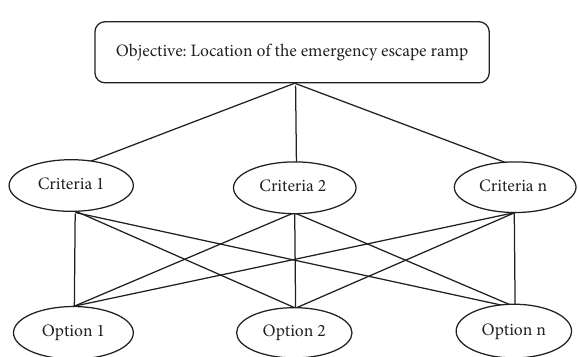
Figure 2: Schematic representation of a hierarchical